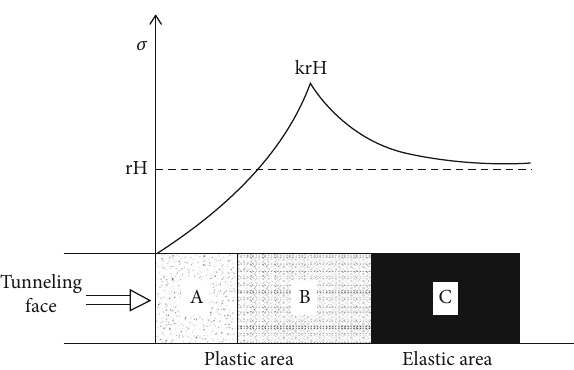
Figure 1: Schematic diagram of regional distribution of mining stress fi